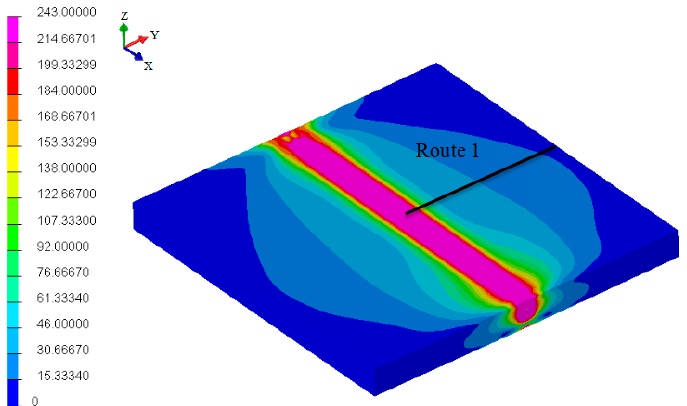
Figure 10. Colored map of the von Mises stress in simulation. The values on the left represent von Mises effective stress, where different colors indicate different stress values, and route 1 (black line) was chosen to compare the principal stress between simulation and experiment.